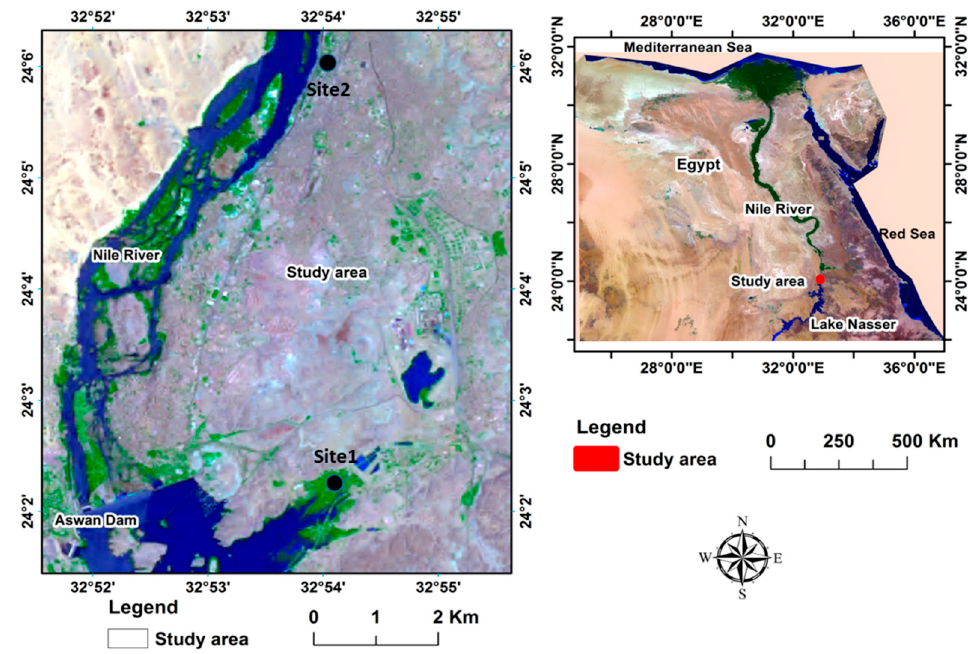
Figure 1. Location of study area in Egypt (right) and detailed features (left).